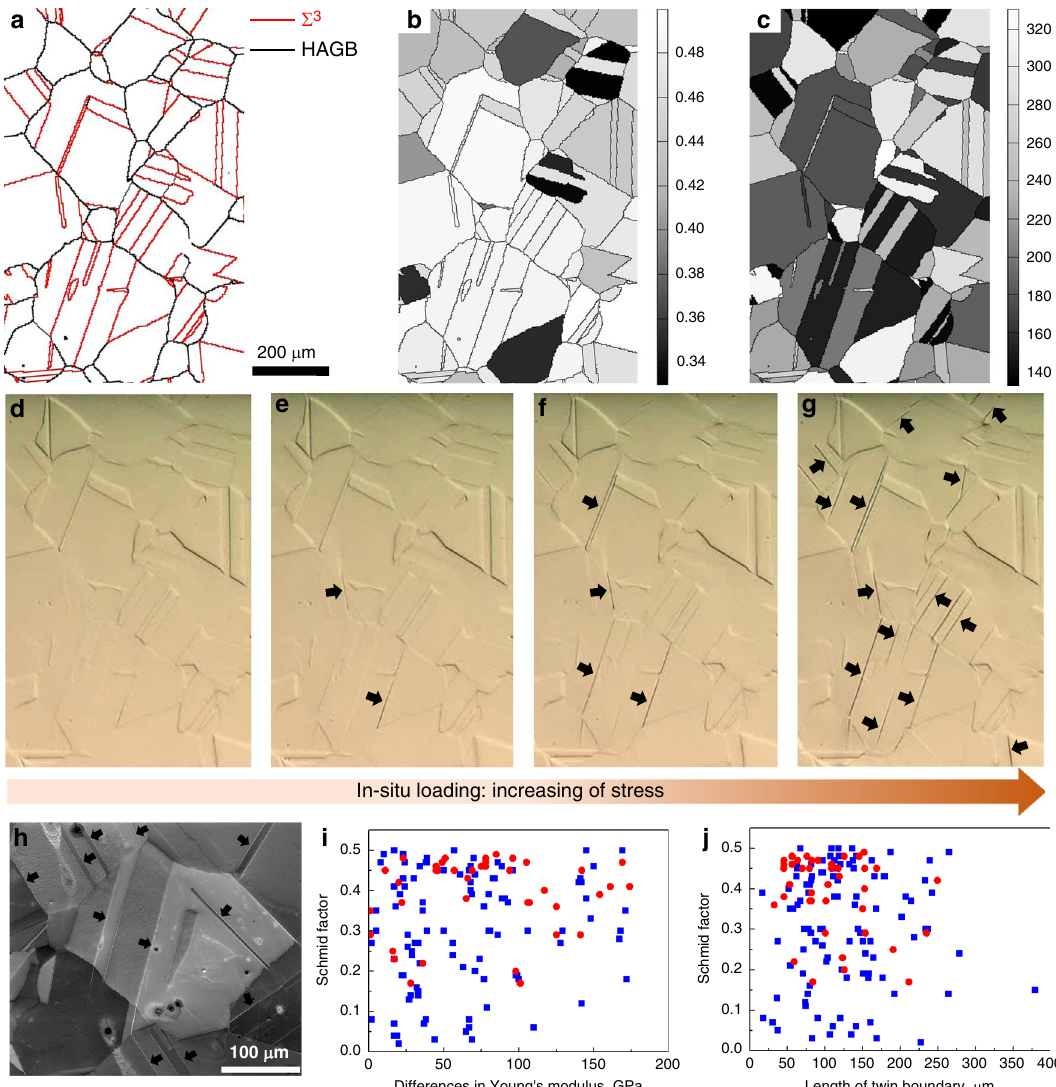
Fig. 3 In-situ observation of the development of slip traces at TBs during tensile loading and statistical analysis of slip traces generated at TBs. a – c Microstructural information of a region of interest tracked during in situ loading, a grain boundary map obtained by EBSD; b Schmid factor map; c Young ’ s modulus map with unit in GPa; d – g snapshots taken during in situ tensile loading and visible slip traces are indicated by black arrows, and tensile axis is horizontal; h a SE image of a region from the sample after tensioning to a strain of 1%, and slip traces along TBs are indicated by black arrows; i , j Statistics of 150 TBs which have developed slip traces (red solid circles) and have not developed slip traces (blue solid squares) in a sample after tensioned to a strain of 1%, i diagram of Schmid factor versus the differences in Young ’ s modulus across TBs; j diagram of Schmid factor versus the length of